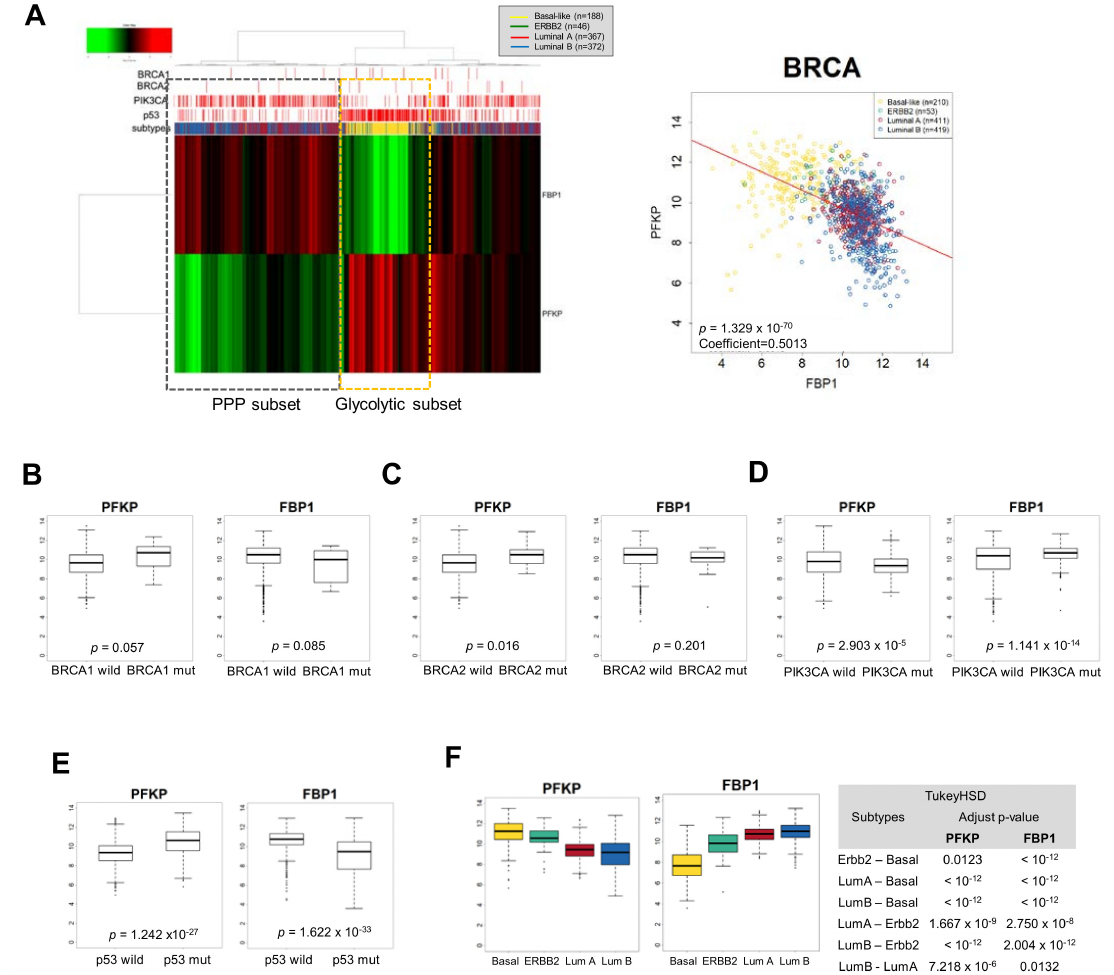
Figure 2. Mutual exclusive and di ff erential expression of PFKP and FBP1 according to the breast cancer subtypes. ( A ) Unsupervised hierarchical cluster analysis of breast cancer patient samples in The Cancer Genome Atlas (TCGA) using PFKP and FBP1 to discriminate metabolic subsets with mutational status of BRCA1 / 2, PIK3CA, and p53 (left panel). Luminal subtypes show PFKP suppression with PIK3CA mutation (PPP dependent subset), while basal-like subtype shows FBP1 suppression (glycolytic subset) having p53 mutation. Pearson distance analysis with a negative distance correlation of PFKP and FBP1 with divergent clusters of breast cancer subtypes (right panel, coe ffi cient = − 0.501, p < 0.001). ( B – F ) Comparison of PFKP or FBP1 transcript abundances according to mutational status of BRCA1 (wt, n = 956; mut, n = 17) ( B ), BRCA2 (wt, n = 956; mut, n = 17) ( C ), PIK3CA (wt, n = 657; mut, n = 316) ( D ), and p53 ( n = 675; mut, n = 298) ( E ) and breast cancer subtypes ( F ). Statistical significance was determined by Tukey’s HSD (honestly significant di ff erence)